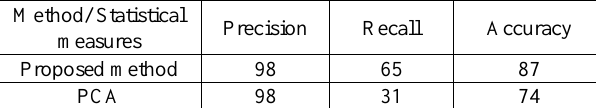
Table 11. Results of check point analysis using down-sampled